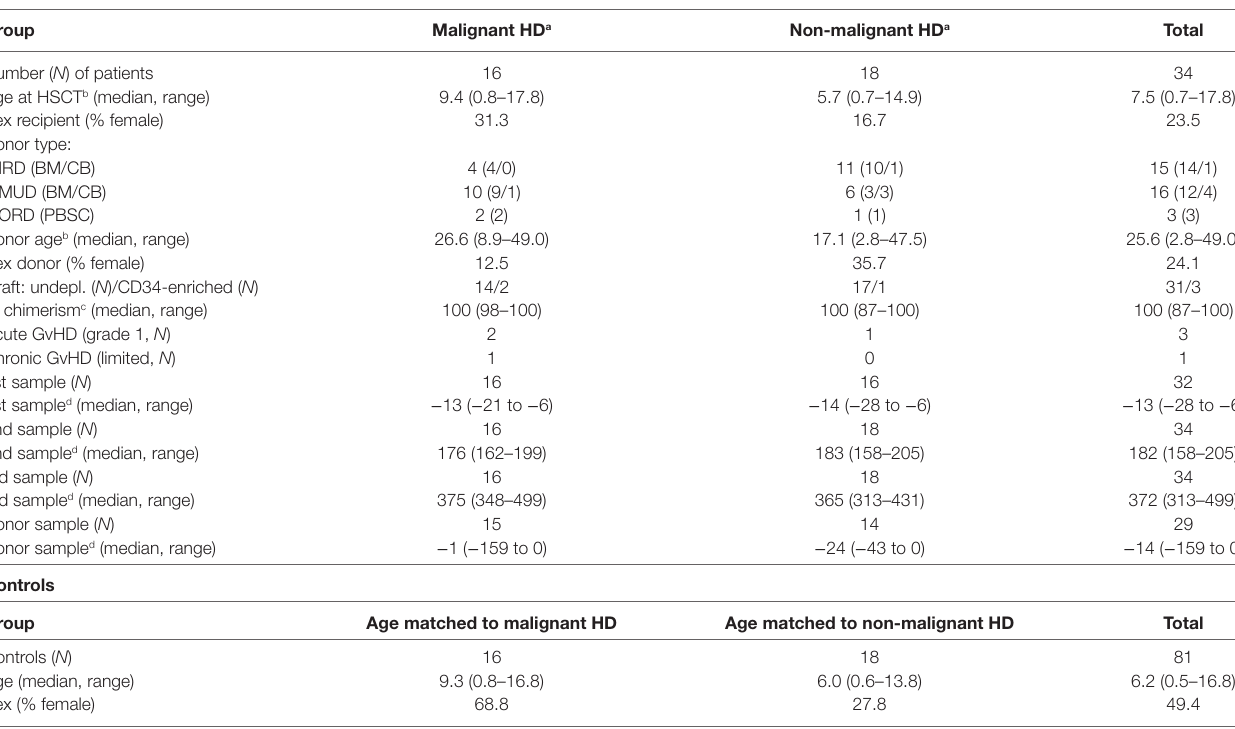
Table 1 | Summary of the cohort. Patients